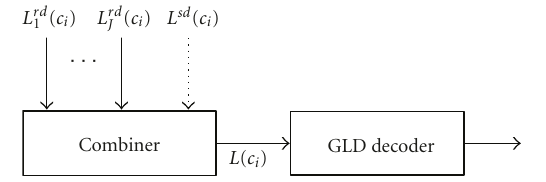
Figure 4: The receiver structure at the destination.